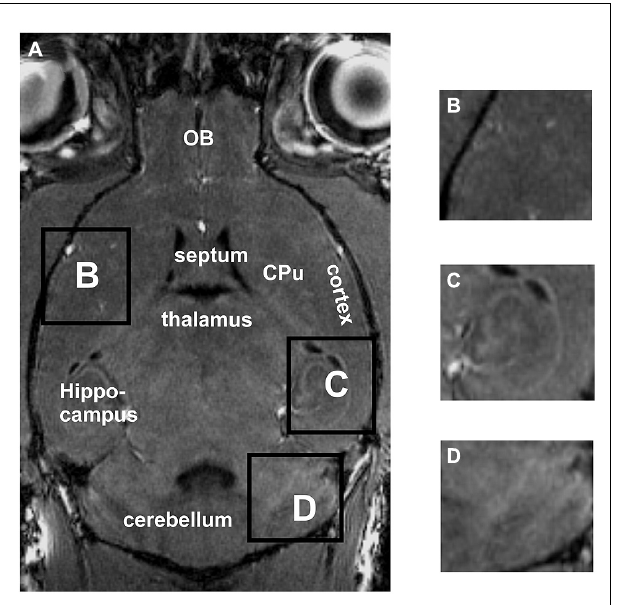
FIGURE 1 | By using in vivo tissue, the brain and the surrounding tissue are clearly visible (A). However, the boundaries between the cortex and the CPu are difficult to detect (A , B) . Neither the hippocampal fields CA1, CA3 nor the dentate gyrus can clearly be distinguished (C) .Within the cerebellum (D) the different layers cannot be differentiated. Inserts B,C,D represent magnifications of areas shown in A . CPu, caudate putamen; OB, olfactory